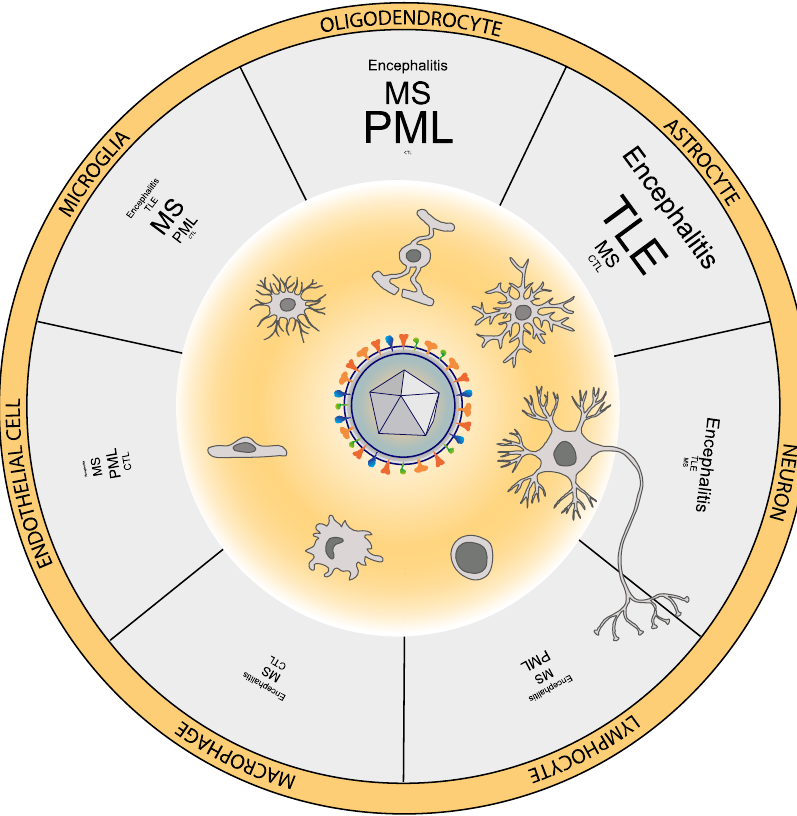
Figure 1. Cell types with positive immunoreactivity against human herpesvirus 6 (HHV-6) antigens across studies. MS: Multiple sclerosis, TLE: Temporal lobe epilepsy, PML: Progressive multifocal encephalopathy. The size of the text indicating each neurological condition is scaled according to the proportion of studies of each condition in which the cell type is detected by immunohistochemistry. For example, most cases of encephalitis or TLE describe staining in astrocytes but almost none in controls (CTL).